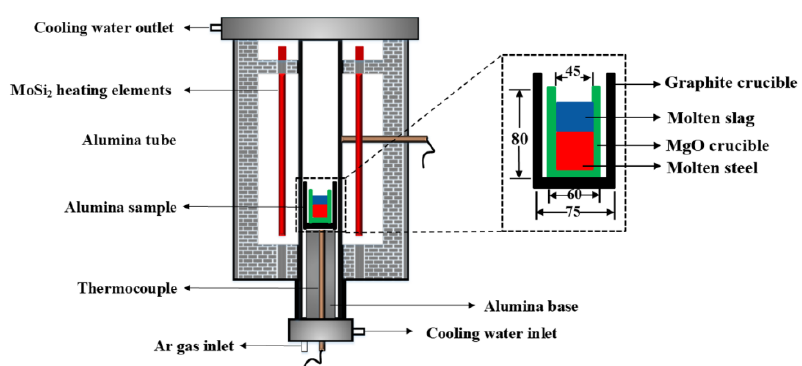
Figure 1. Schematic of apparatus for the steel–slag reaction. Table 3. Initial composition of mold fluxes and steel for the contact experiment (wt%).